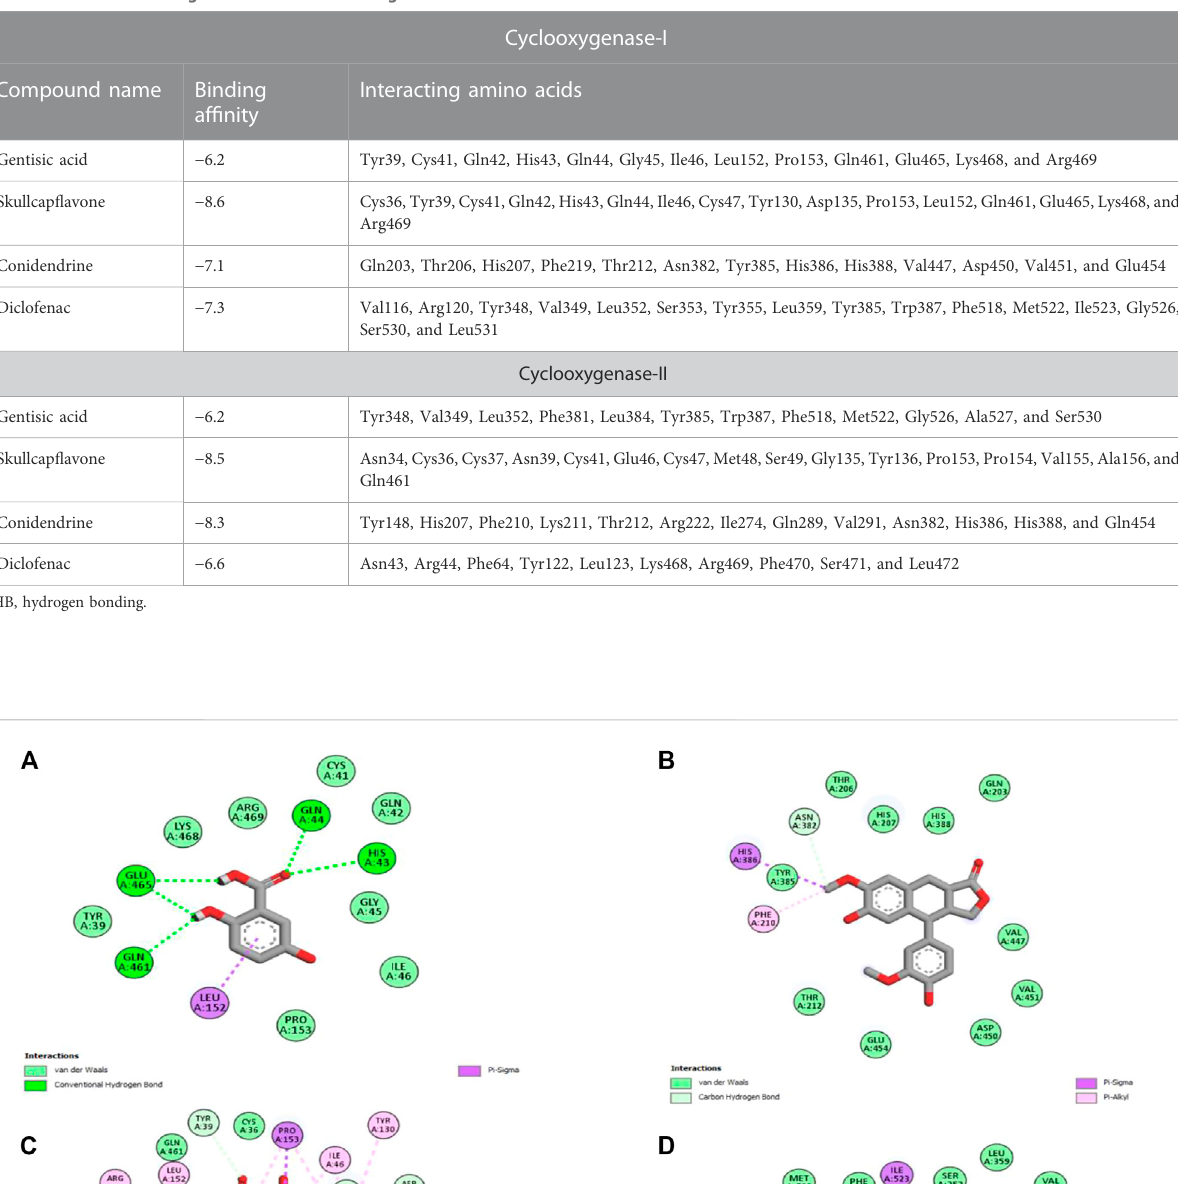
TABLE 5 Details of binding af fi nities and interacting amino acid